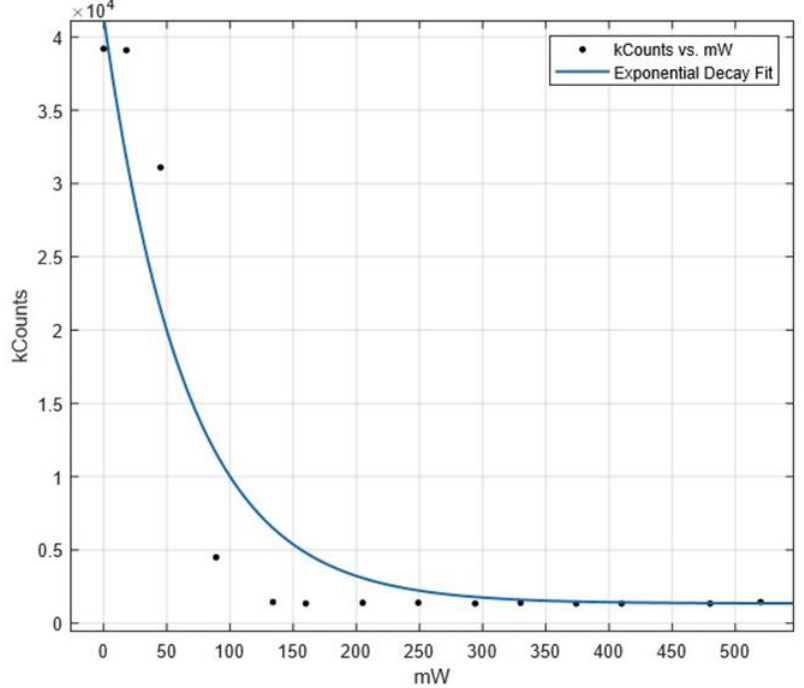
Figure 5. Quenching of the Singlet States.